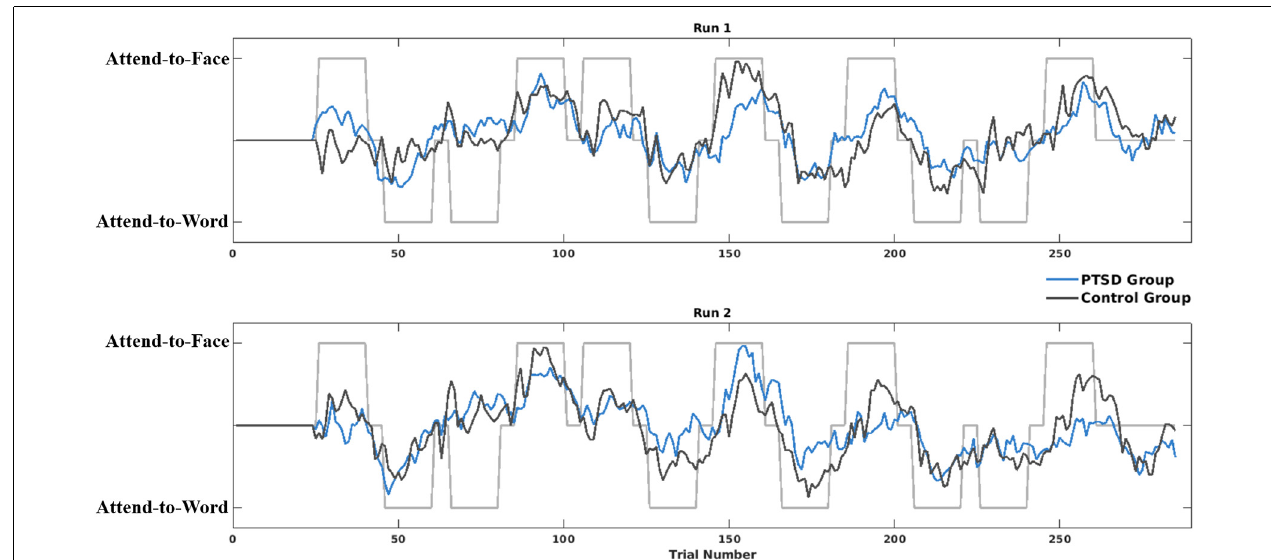
FIGURE 5 | Hyperplane distance (HD) of both PTSD and control groups across all trials of both A-NF runs, plotted over the task labels (“attend-to-face” = 1, “attend-to-word” = − 1). HD values quantify the degree to which the individual’s current brain state resembles the brain state encoding the training labels (based on training runs). Therefore, HDs more closely matching the task label reflect brain states more closely matching the brain state used to train the SVM